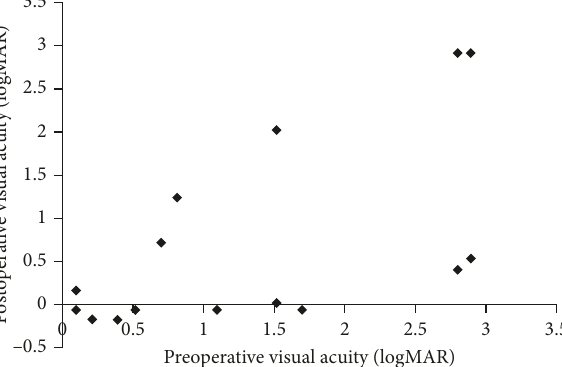
Figure 1: Preoperative and postoperative visual acuities.